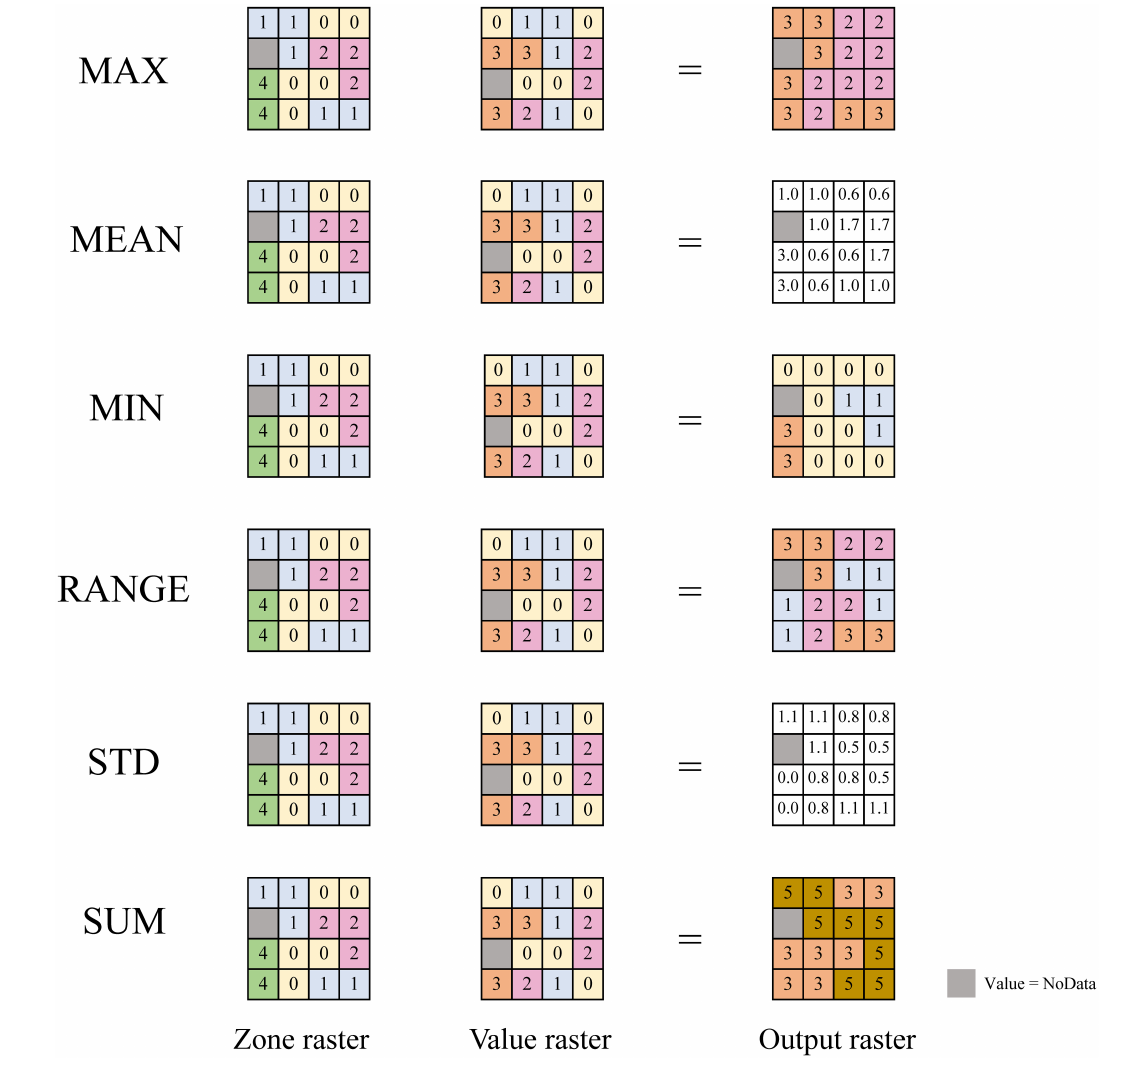
FIGURE1 Regional climate indicator. Zone raster: defines the zones, same number for the same area, different numbers for different areas. Value raster: contains the climatic input values used in calculating the output for each zone. Output raster: the result of the statistic applied to the climatic value input. Refer to the zonal statistics description in ArcGIS. MAX, the largest value of all cells in the value raster that belong to the same zone as the output cell will be calculated; MEAN, the average of all cells in the value raster that belong to the same zone as the output cell will be calculated; MIN, the smallest value of all cells in the value raster that belong to the same zone as the output cell will be calculated; RANGE, the difference between the largest and smallest value of all cells in the value raster that belong to the same zone as the output cell will be calculated; STD, the standard deviation of all cells in the value raster that belong to the same zone as the output cell will be calculated; SUM, the total value of all cells in the value raster that belong to the same zone as the output cell will be